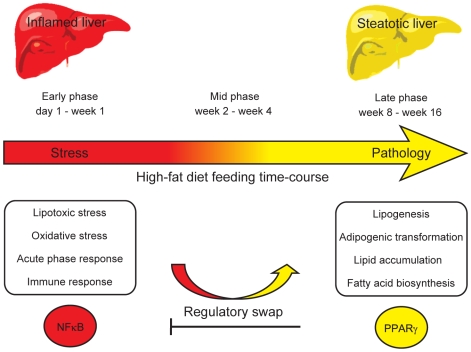
Model of the hepatic physiological response to high-fat diets during the 16-week time-course.The summary of a proposed model for the hepatic physiological changes in response to high-fat diets during the 16-week time-course in ApoE3L mice. The initial perturbation of hepatic homeostasis by excess dietary fat triggers the stress response largely controlled by NF-κB and Akt regulators and manifested in activation of acute phase response, inflammation, immune response, hepatic regeneration-like response and lipotoxicity (day 1 to week 1). Upon prolonged high-fat feeding, liver fails to regain the basal state and consequently shifts to pathological state controlled by PPAR and SREBP regulators and characterized by hepatic lipid accumulation and adipogenic transformation, indicative of hepatic steatosis (late phase, week 8 to week 16). The flagship processes induced at the early and at the late phase are shown in boxes. The transition between the stressed and the pathological hepatic state may be controlled by trans-inhibitory interactions between NF-κB and PPARγ regulators, resulting in the tradeoff between inflammatory and steatotic transcription programs (mid phase, week 2 to week 4). On the systems level, the activation of steatotic program is followed by other metabolic syndrome associated pathologies such as obesity and whole-body insulin resistance.